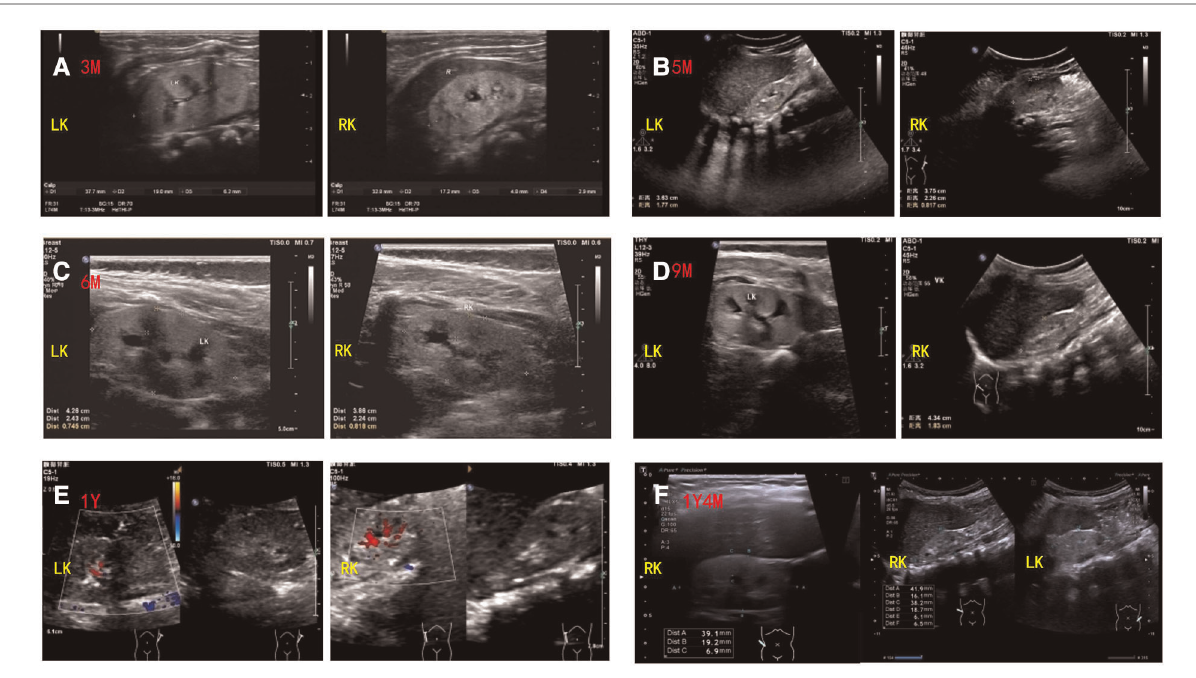
FIGURE 2 Renal ultrasound fi ndings of the patient. Ultrasound showed bilateral hypodysplastic kidneys with enhanced echogenicity and obtained corticomedullary differentiation. The size and thickness of left and right kidneys of the patient are as follows: ( A ) 3 months: 38 mm×19 mm, 6.2 mm and 34 mm×17 mm, 4.8 mm (reference range: 55.7 – 64.1 mm×32.2 – 36.2 mm, 23.1 – 28.1 mm and 55.4 – 63.8 mm×29.4 – 33.4 mm, 22.3 – 26.9 mm); ( B ) 5 months: 38 mm×22 mm, 8.1 mm and 36 mm×17 mm, 6.4 mm (reference range: 55.7 – 64.1 mm×32.2 – 36.2 mm, 23.1 – 28.1 mm and 55.4 – 63.8 mm×29.4 – 33.4 mm, 22.3 – 26.9 mm); ( C ) 6 months: 43 mm×24 mm, 7.4 mm and 41 mm×21 mm, 8.0 mm (reference range: 55.7 – 64.1 mm×32.2 – 36.2 mm, 23.1 – 28.1 mm and 55.4 – 63.8 mm×29.4 – 33.4 mm, 22.3 – 26.9 mm); ( D ) 9 months: 45 mm×25 mm, 7.4 mm and 43 mm×21 mm, 7.6 mm (reference range: 62.3 – 67.3 mm×34.2 – 37.2 mm, 24.9 – 29.7 mm and 61.6 – 67.4 mm×33.7 – 37.3 mm, 23.7 – 30.1 mm); ( E ) 1 year: 41 mm×19 mm, 8.1 mm and 42 mm×18 mm, 6.8 mm (reference range: 62.3 – 67.3 mm×34.2 – 37.2 mm, 24.9 – 29.7 mm and 61.6 – 67.4 mm×33.7 – 37.3 mm, 23.7 – 30.1 mm); ( F ) 1 year and 4 months: 40 mm×19 mm, 6.1 mm and 41 mm×19 mm, 6.5 mm (reference range: 62.3 – 67.3 mm×34.2 – 37.2 mm, 24.9 – 29.7 mm and 61.6 – 67.4 mm×33.7 – 37.3 mm, 23.7 – 30.1